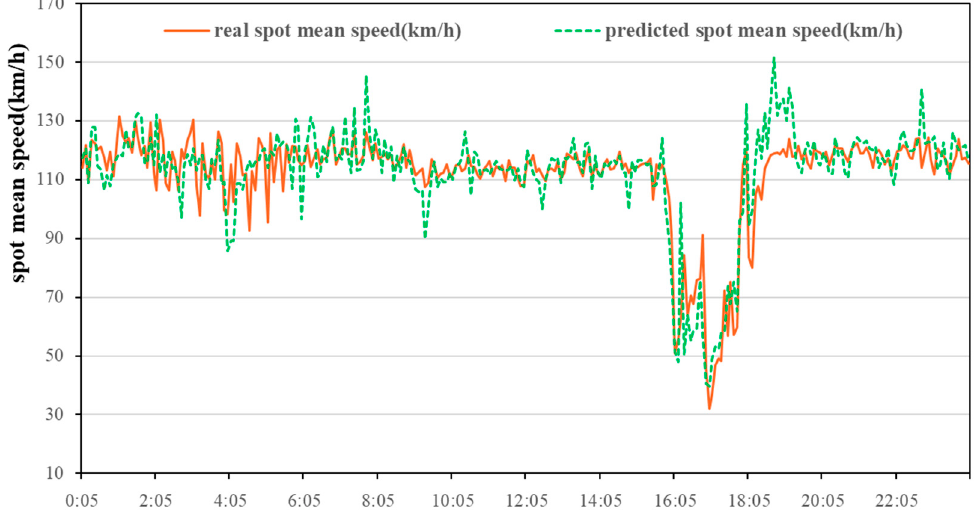
Figure 2. Spot mean velocity and predicted interval mean velocity on Minnesota highway.